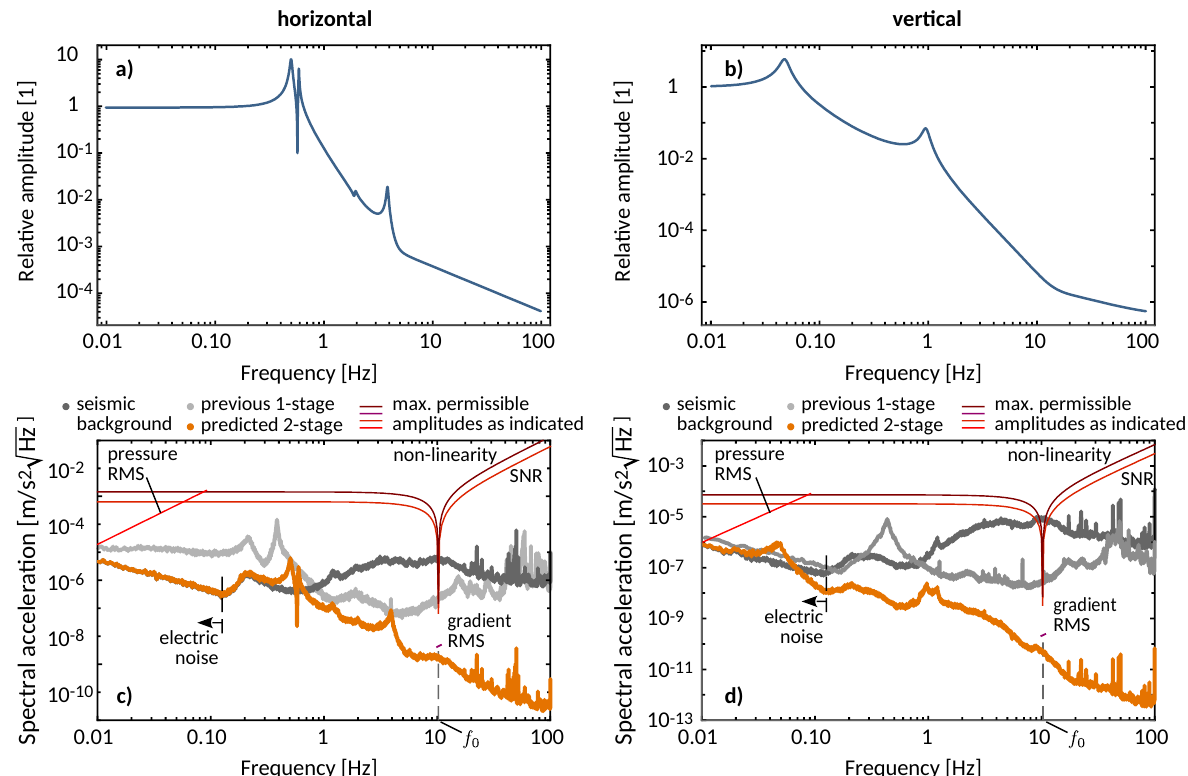
Figure 5. Preliminary predicted performance of the improved C ANNEX SAS. Left graphs: horizontal vibrations; right graphs: vertical vibrations. ( a , b ) Computed spectral attenuation factor of the improved SAS. ( c , d ) Measured spectral seismic acceleration background and predicted level for the core chamber. Maximum admissible amplitudes computed from requirements on the RMS noise, non-linearities, and the signal-to noise ratio (SNR) influencing measurements in a non-trivial way (discussed in the appendix) are given as red lines of different hue. Below ∼ 0.1Hz, electronic 1/ f noise dominates the signal of our seismic measurements. The actual seismic level, thus, lies below the curves at these